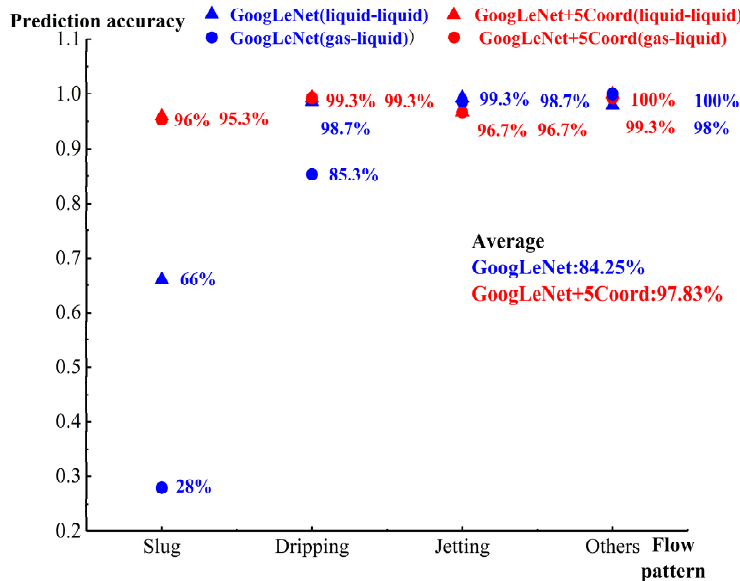
Figure 9. Prediction accuracy of two-phase flows.